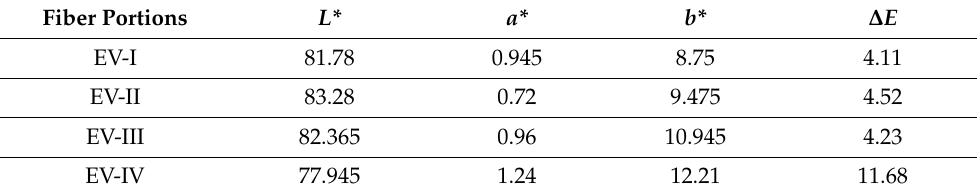
Table 3. CIE Lab values of fiber